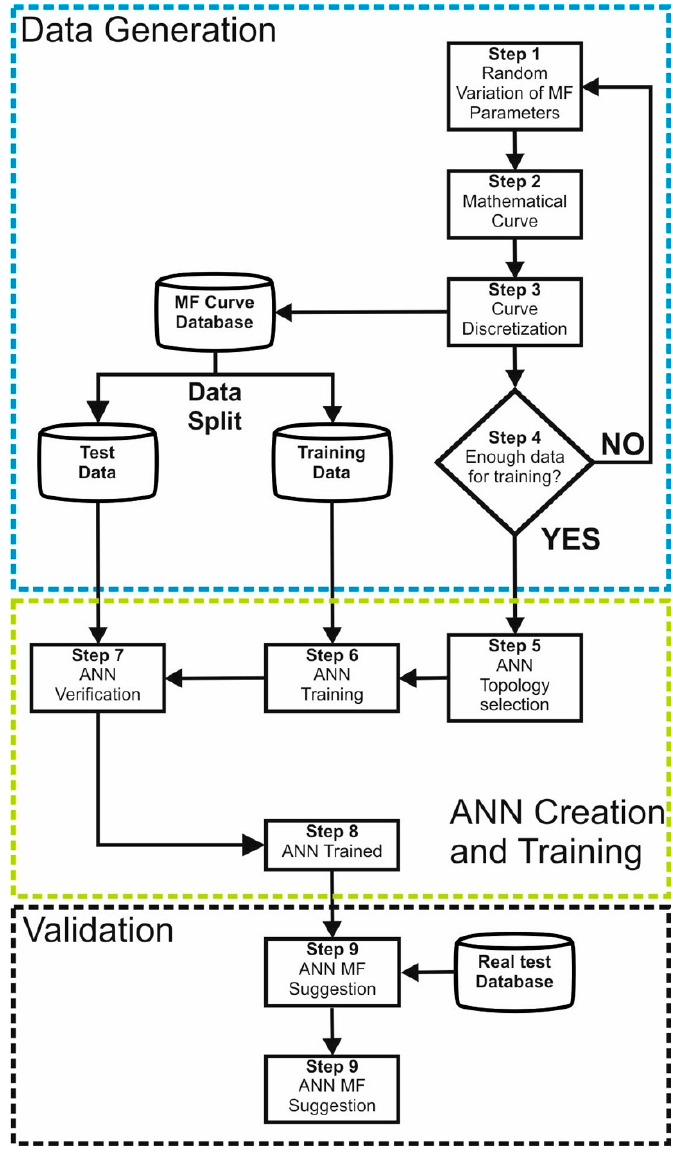
Figure 2. ANN learning and verification flowchart.